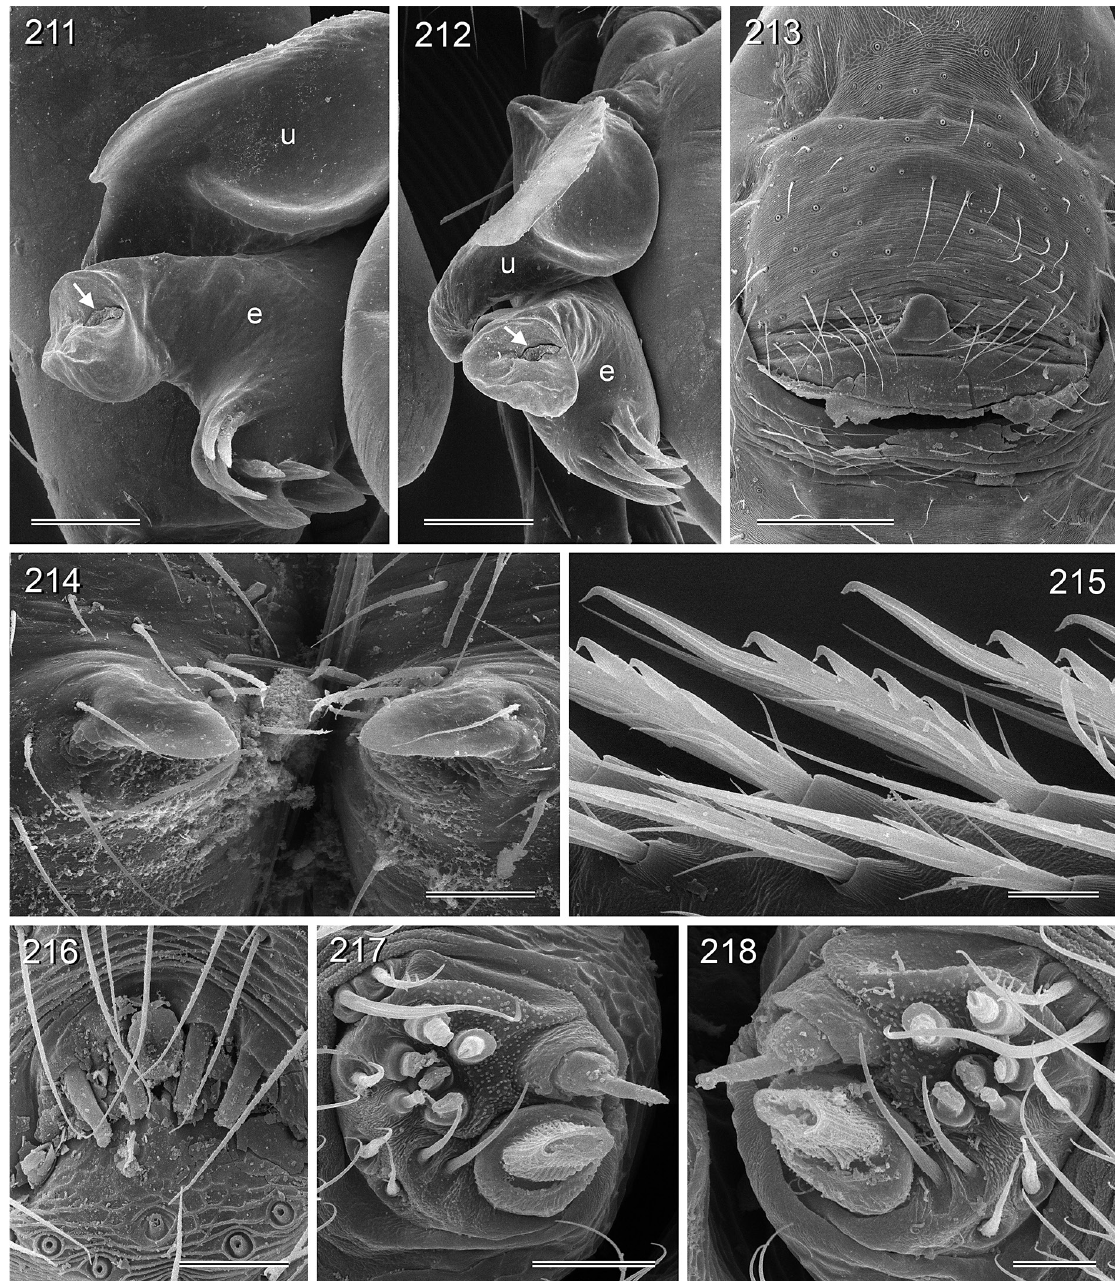
Figs 211–218. Pholcus lambir Huber, sp. nov., ZFMK Ar 15060–61. 211–212 . Left bulbal processes, prolateral (slightly distal) and ventral views (arrows point at sperm duct opening). 213 . Epigynum, ventral view. 214 . Distal male cheliceral apophyses. 215 . Comb-hairs on male tarsus 4. 216 . Male gonopore. 217–218 . Female and male ALS. Abbreviations: e = embolus; u = uncus. Scale lines: 10 µm (215, 218); 20 µm (217); 30 µm (214, 216); 60 µm (211); 80 µm (212); 200 µm